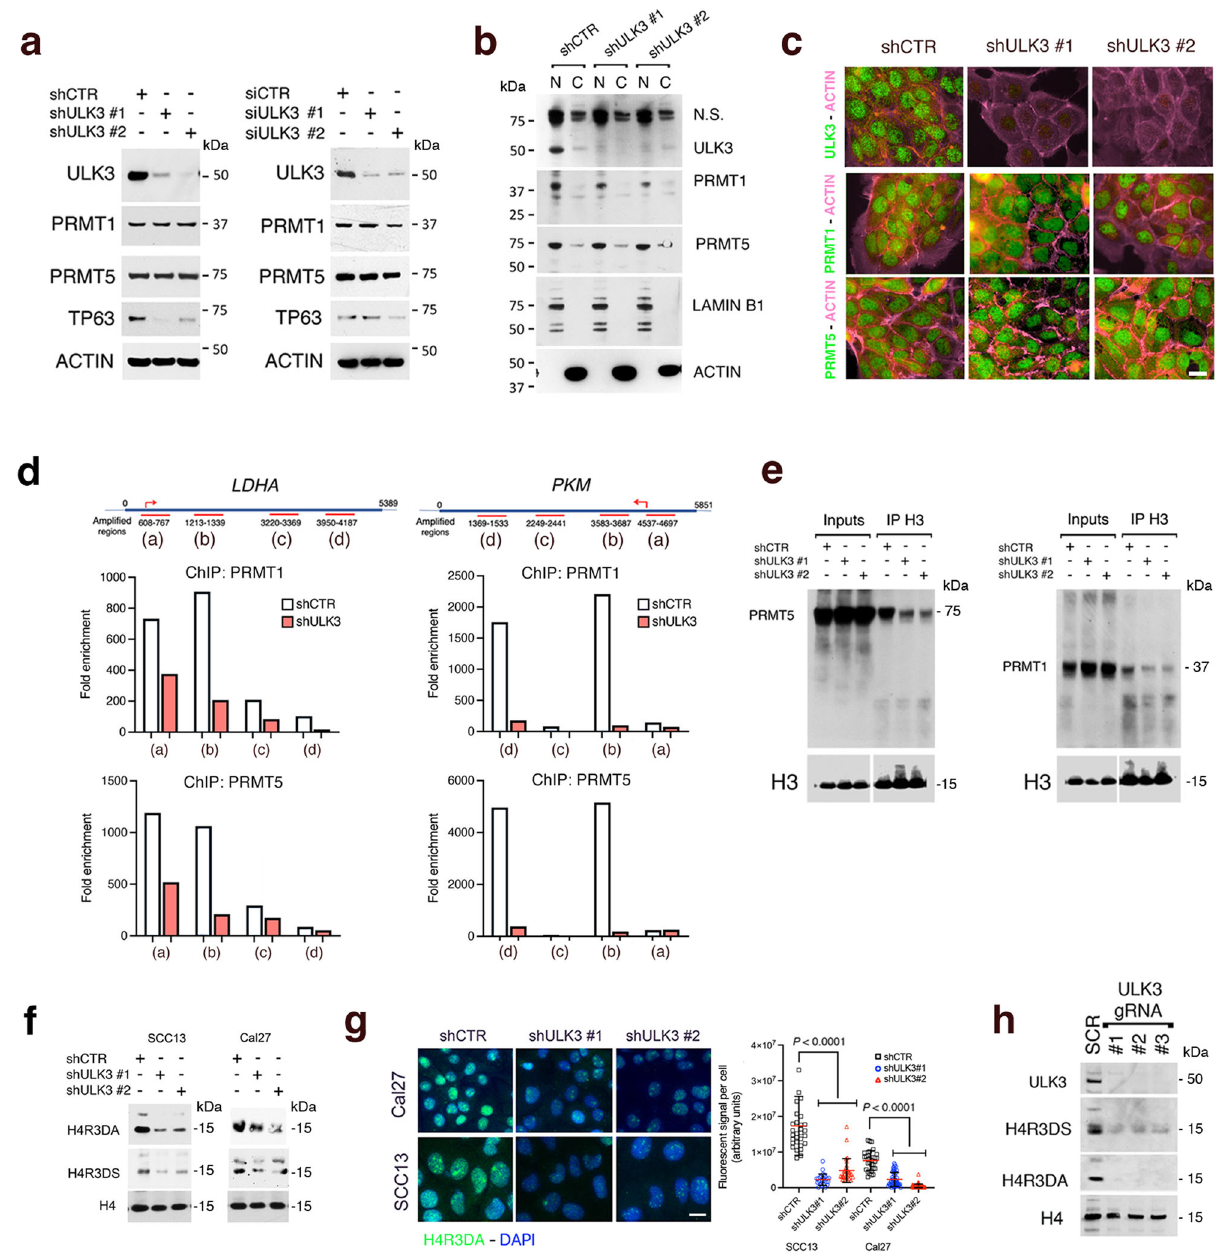
Fig. 8 | ULK3 loss impairs PRMT1/5 chromatin association and function. a ImmunoblotsagainsttheindicatedproteinsofSCC13cellswith ULK3 silencingby two shRNAs (shULK3 #1, #2) for 1 week or with two siRNAs (siULK3#1, 2) for 48h, with corresponding controls. b Immunoblots of nuclear (N) and cytosolic (C) fractions from SCC13 cells with ULK3 silencing by two shRNA-speci fi c versus con- trol lentiviruses.The blots were sequentially probed with the indicatedantibodies. c PRMT1,PRMT5andULK3immunostaining(green)ofSCC13cellsplus/minus ULK3 silencing with two lentiviruses versus control virus. Phalloidin labeled actin cytos- keleton (magenta). Scalebar 5 µ m. d ChIP with anti -PRMT1and -PRMT5antibodies fromSCC13cellsplus/minus ULK3 silencingfollowedbyqPCRampli fi cationoffour regions of the PKM and LDHA genes. The position of ampli fi ed regions (magenta lines)andTSS(arrow)areshown.Resultsareexpressedasenrichmentfoldrelative to IgGs as in 18 . e ChIPs with anti-histone 3 (H3) antibodies followed by PRMT1, PRMT5 and H3 immunoblotting from SCC13 cells plus/minus ULK3 silencing. For H3, the immunoblots of inputs and immunoprecipitations are shown at different